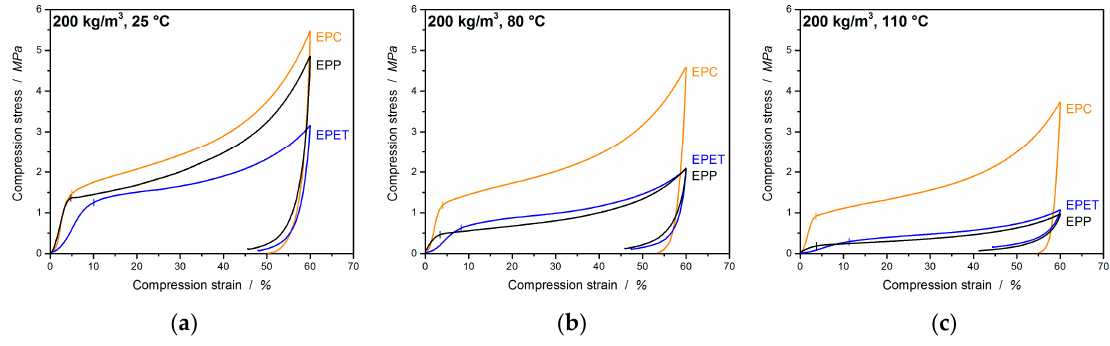
Figure 4. Stress–strain curves under compressive loading of EPC, EPP, and EPET at 25 ( a ), 80 ( b ), and 110 °C ( c ).